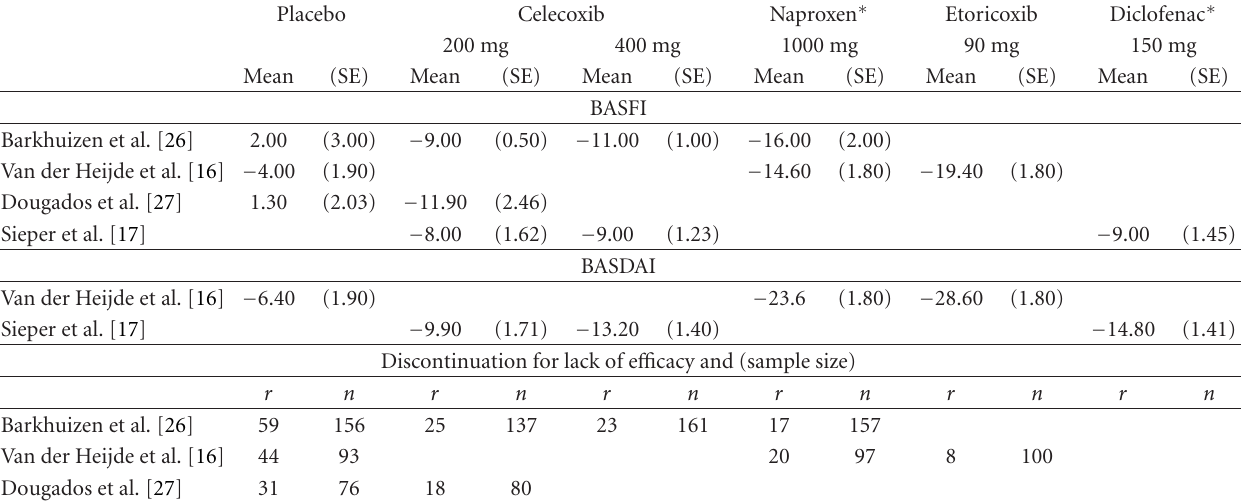
Table 2: Individual studies and results included for mixed treatment comparison of BASFI, BASDAI and discontinuation due to lack of e ffi cacy.